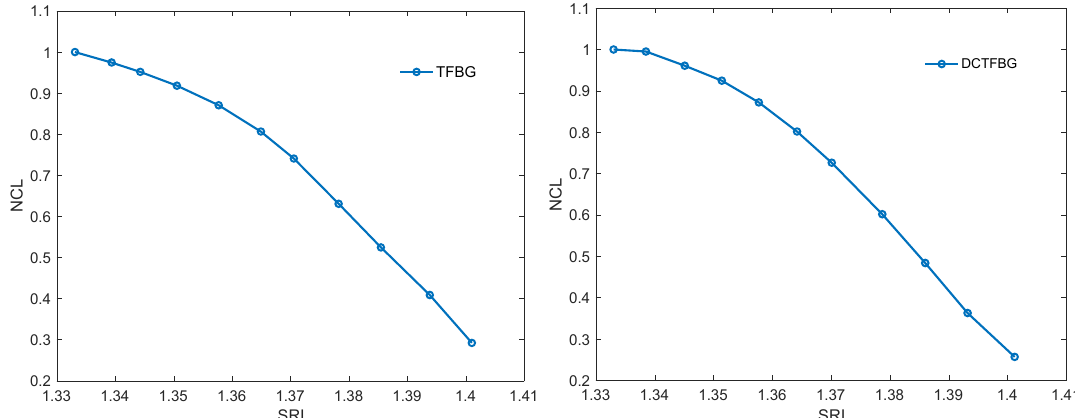
Figure 12. Change of the normalised contour length from SRI for the TFBG and DC-TFBG.